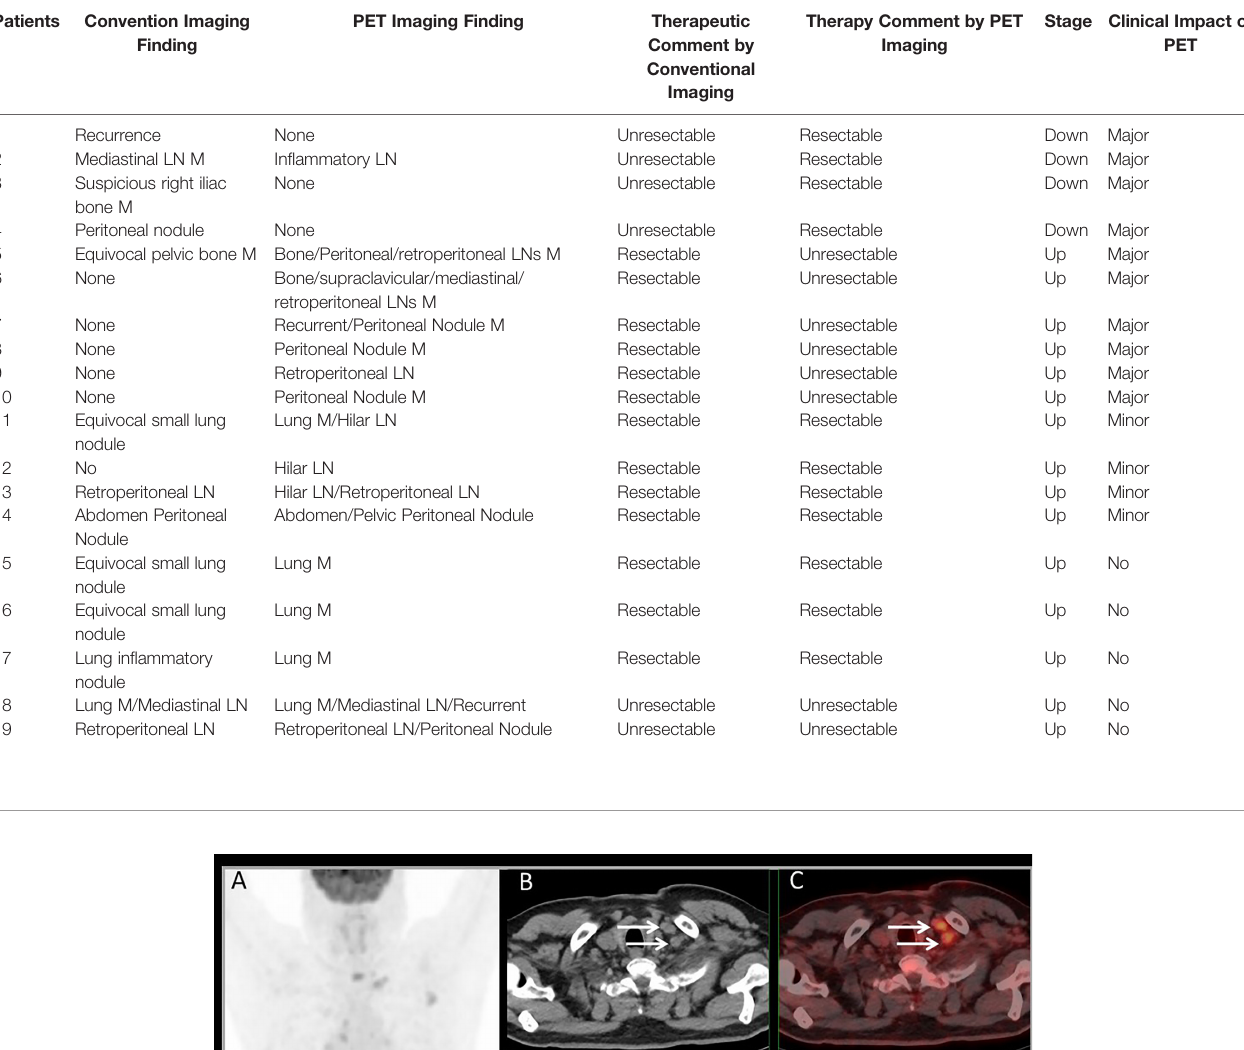
TABLE 3 | Additional PET fi ndings in all 19 patients and the clinical impact.